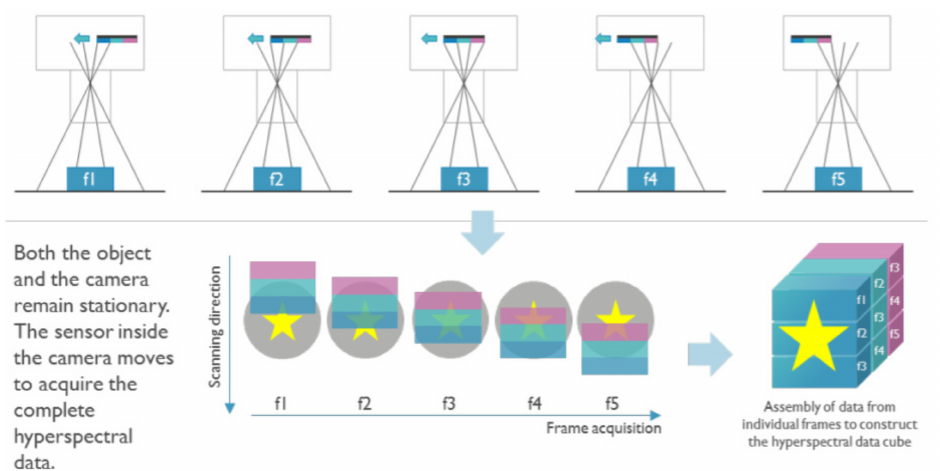
Figure 12. The working principle of the proposed snapscan HIS